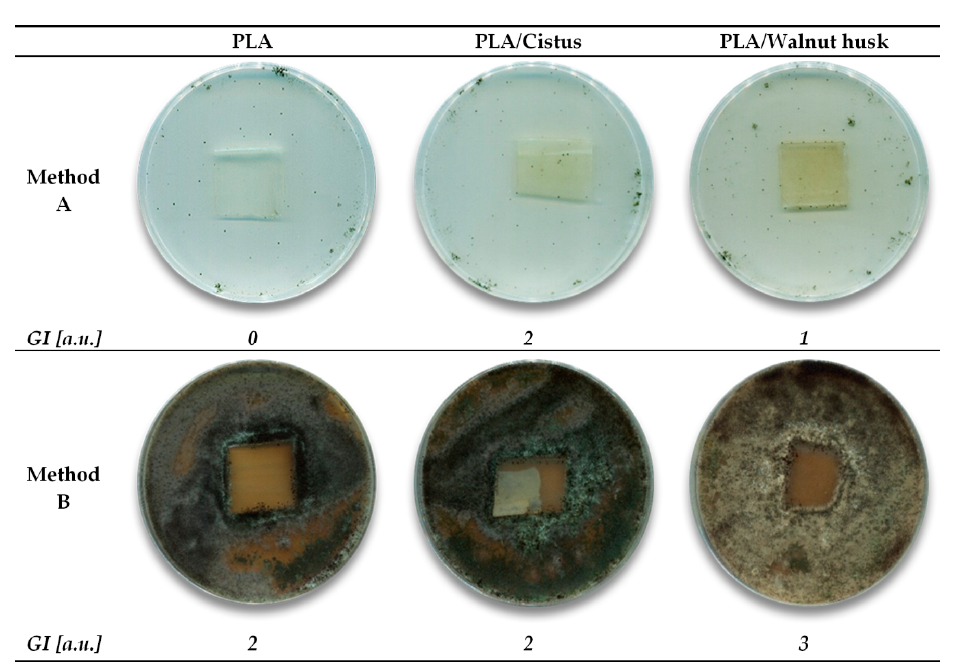
Table 2. Determination of the influence of mold fungi on PLA—methods A and B ( GI—growth intensity ).